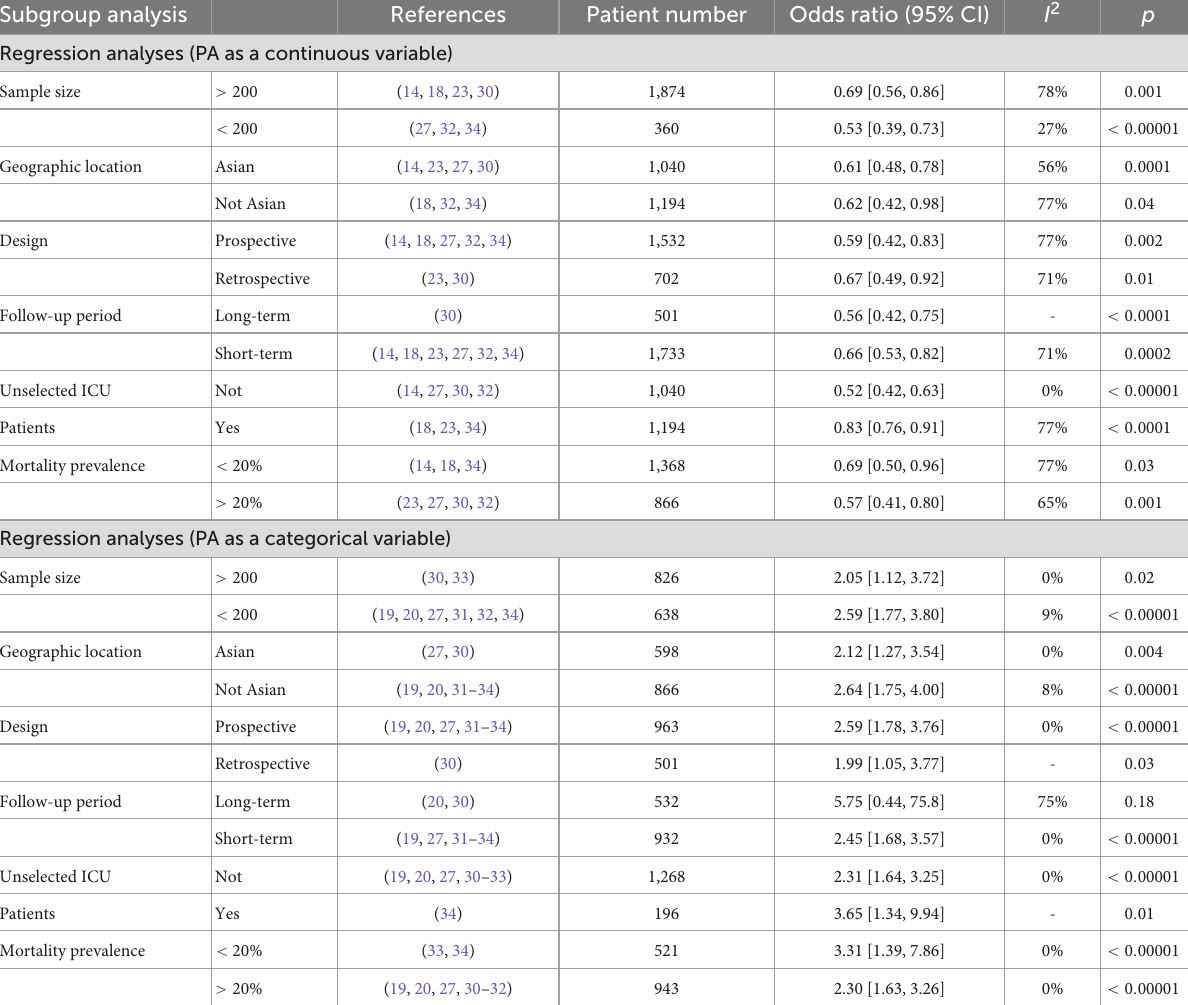
TABLE 4 Subgroup analysis on the association between phase angle (PA) and mortality in critically ill patients. Subgroup